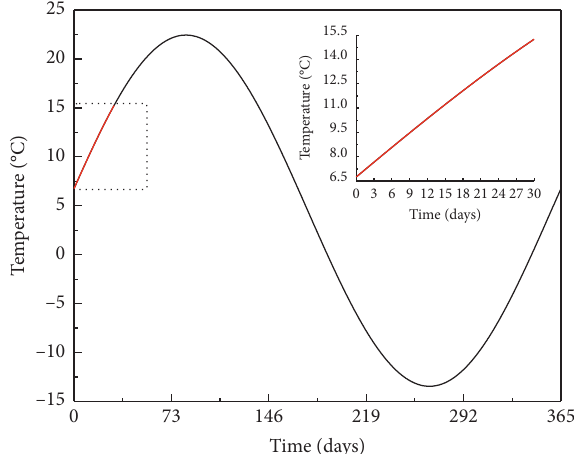
Figure 3: Environment temperature change of the project site.